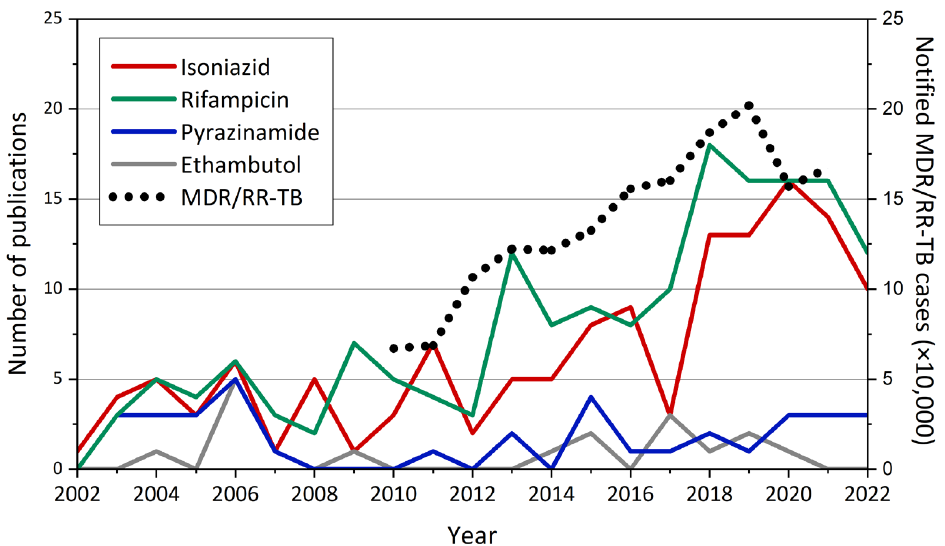
Figure 7. Number of publications discussing the incorporation of first-line antitubercular drugs into nanocarriers. The search was carried out in Scopus in December 2022 using the nanocarriers described in this review as keywords. The dotted line shows the cases of multidrug-resistant/rifampicin-resistant tuberculosis (MDR/RR-TB) according to the annual reports of the World Health Organization. The drop in diagnosed cases from 2019 to 2020 is a consequence of the coronavirus pan- demic.